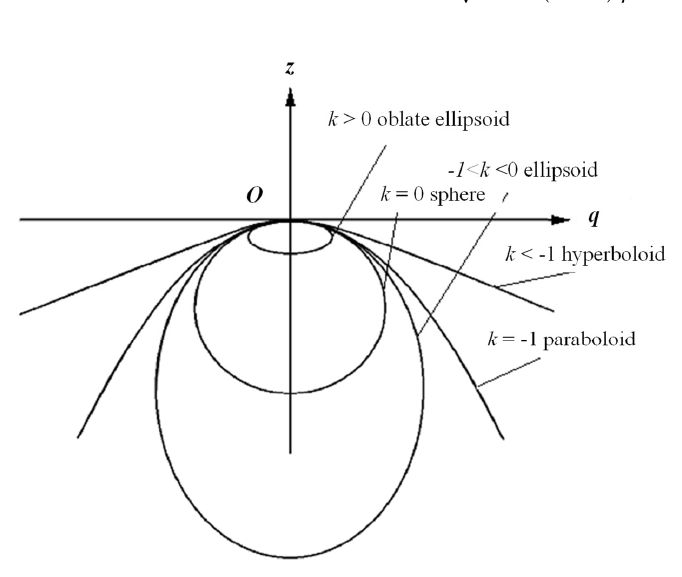
Figure 7. Expression of conic sections and their related conic constants.